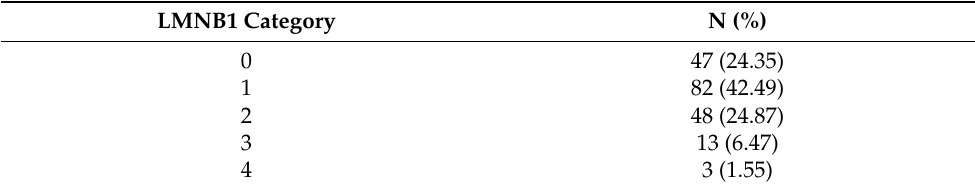
Table 1. Description of LMNB1